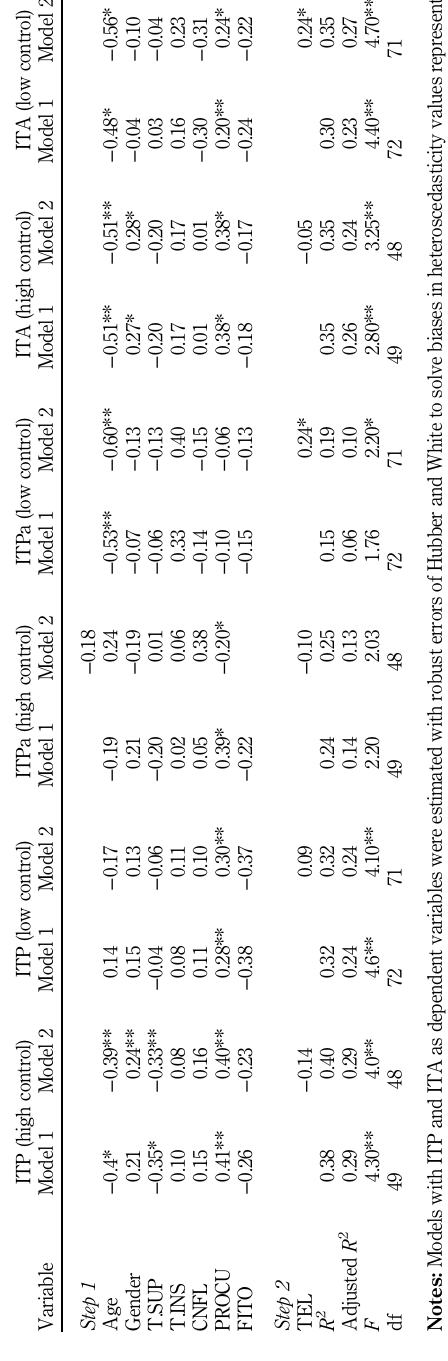
Table III. Hierarchical regression analysis for ITP, ITP and ITA, according to control